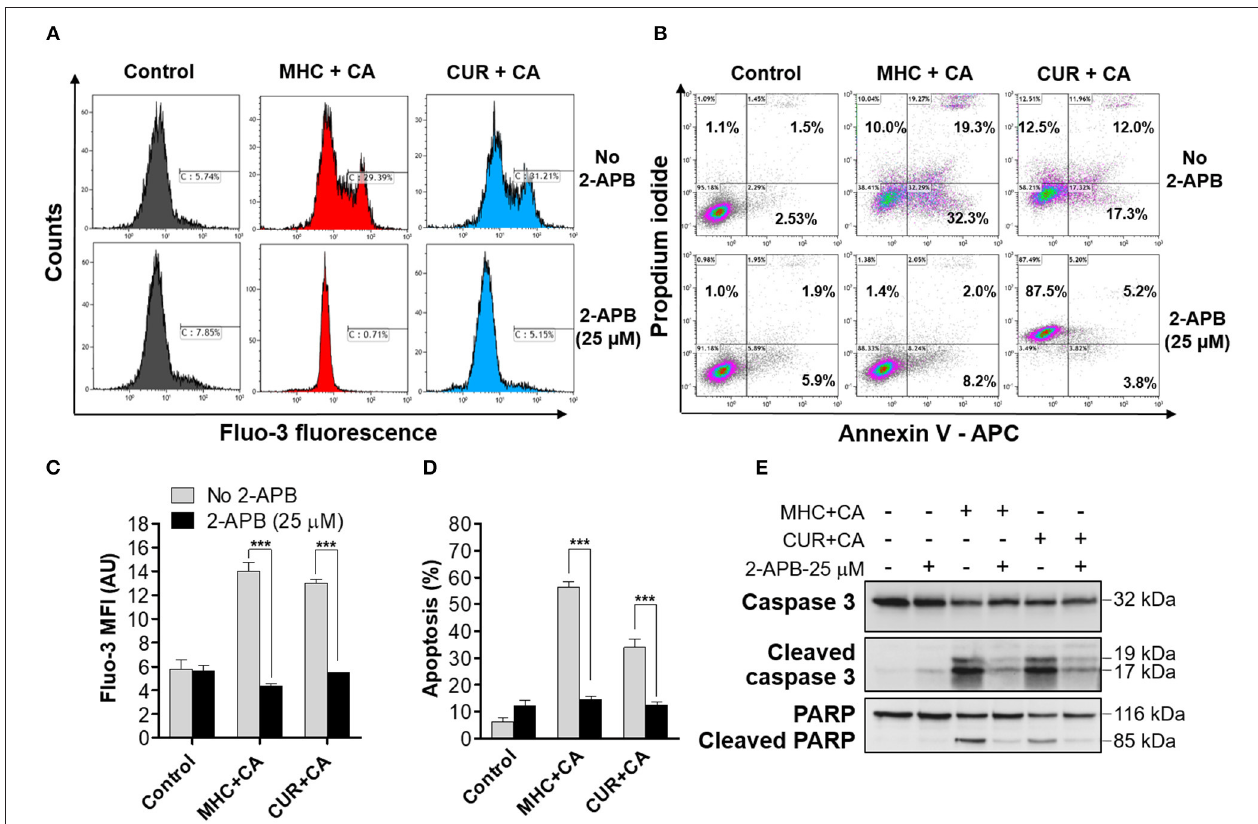
FIGURE 2 | Similar to CUR + CA, the MHC + CA combination induces calcium-dependent apoptosis in the KG-1a cell line. Cells were treated with MHC + CA or CUR + CA in the presence or absence of 2-APB (25 µ M). (A,C) Steady-state cytosolic calcium levels were measured after 4h of incubation. (A) Typical histograms obtained from Fluo-3 loaded cells in a representative experiment. (C) Averaged Fluo-3 MFI ± SD from three independent experiments. (B,D,E) The extent of apoptosis was determined by the annexin V/PI binding assay, after 8h of incubation. (B) Typical flow cytometric data obtained in a representative experiment. The data were analyzed after setting threshold for CUR + CA auto-fluorescence. (D) Averaged percentages of apoptotic cells ± SD ( n = 3). (E) Representative Western blots showing caspase-3 and PARP cleavage ( n = 3). *** p < 0.001; one-way ANOVA with Tukey multiple comparison post-hoc